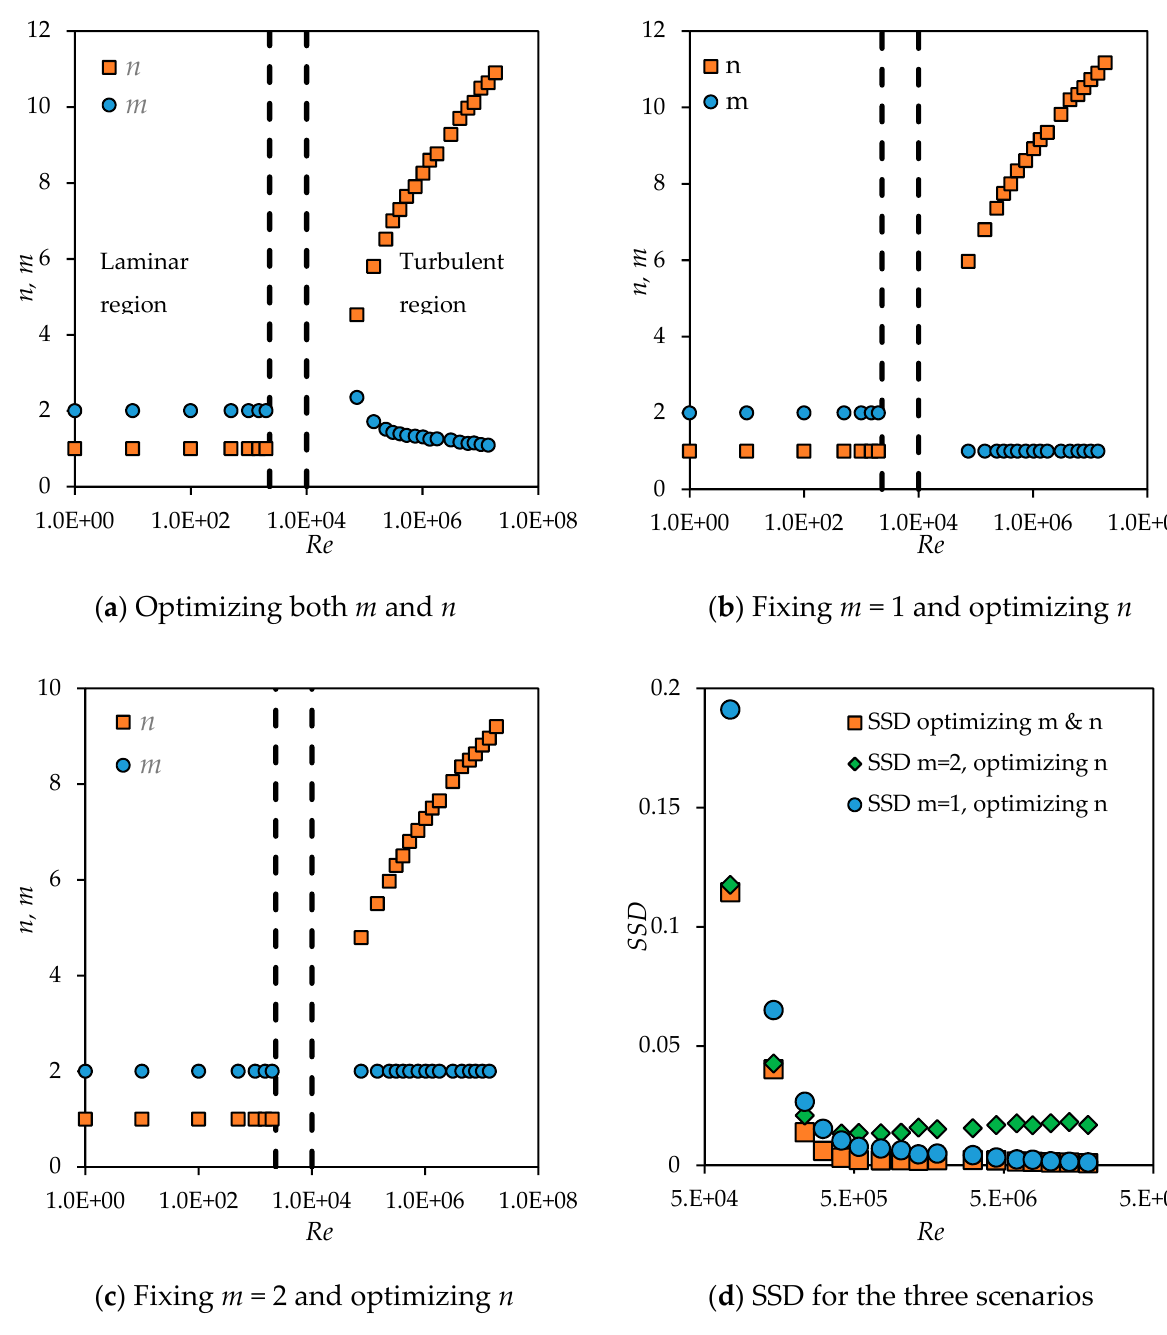
Figure 9. Variations of the optimized two parameters m and n with Reynolds numbers under the following scenarios: ( a ) both parameters are optimized, ( b ) m = 1, and n is optimized, ( c ) m = 2 and n is optimized, and ( d ) is the minimized SSD for the three scenarios with Re .